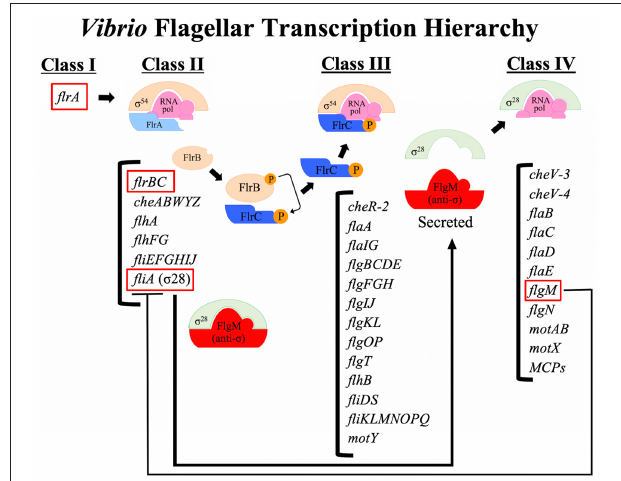
FIGURE 2 | A schematic of the flagellar transcription hierarchy of Vibrio cholerae . V. cholerae flagellar genes are expressed within a four-tiered transcriptional hierarchy. The sole Class I gene of the Vibrio hierarchy is the σ 54 -dependent transcriptional activator, flrA , which is the master regulator of the flagellar hierarchy. The FlrA- and σ 54 -dependent Class II genes encode components of the MS ring, C ring, ATPase and export apparatus associated with the cytoplasmic membrane, components of the chemotaxis machinery, along with proteins that determine the location and number of flagella (discussed in text). The FlrC- and σ 54 -dependent Class III genes encode additional components of the C ring, inner membrane export apparatus, the rod, rod cap, PLH and T rings, torque generator, hook components, filament cap, the FlaA flagellin, the flagellin chaperone, a chemotaxis protein, and proteins of unknown function. The σ 28 -dependent Class IV genes encode additional flagellins, motor components, chemotaxis proteins, and methyl-accepting chemoreceptors